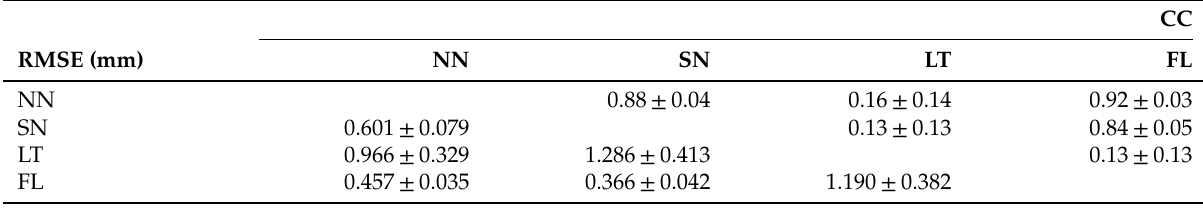
Table 3: Correlation coefficient (CC, values in upper right half of the table) and root mean squared error (RMSE, values in lower left half of the table) between the methods on noisy data.